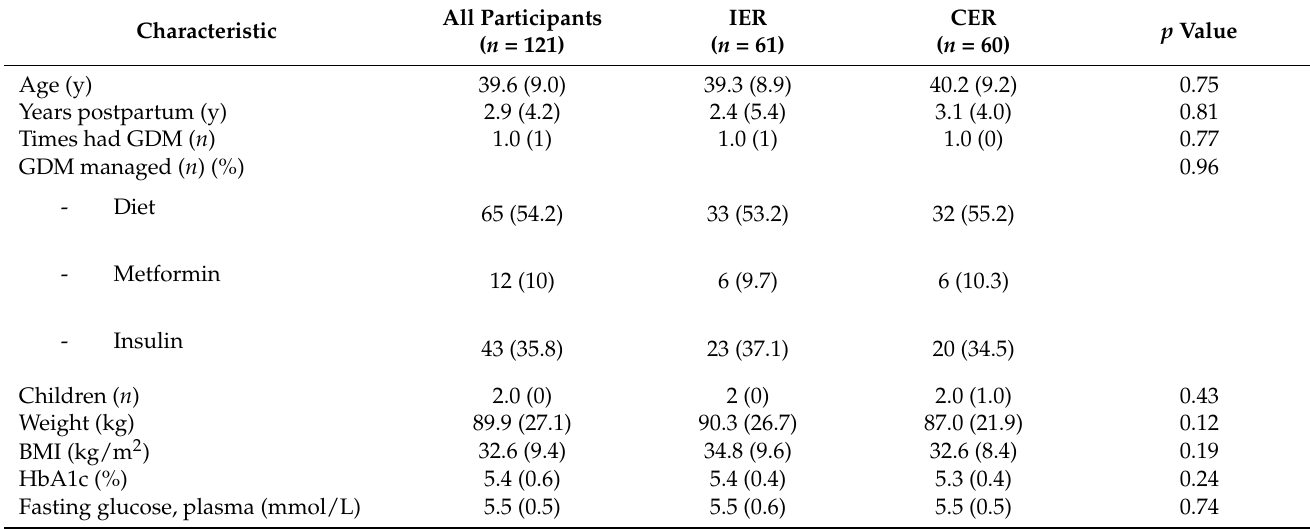
Table 2. Baseline characteristics of participants 1